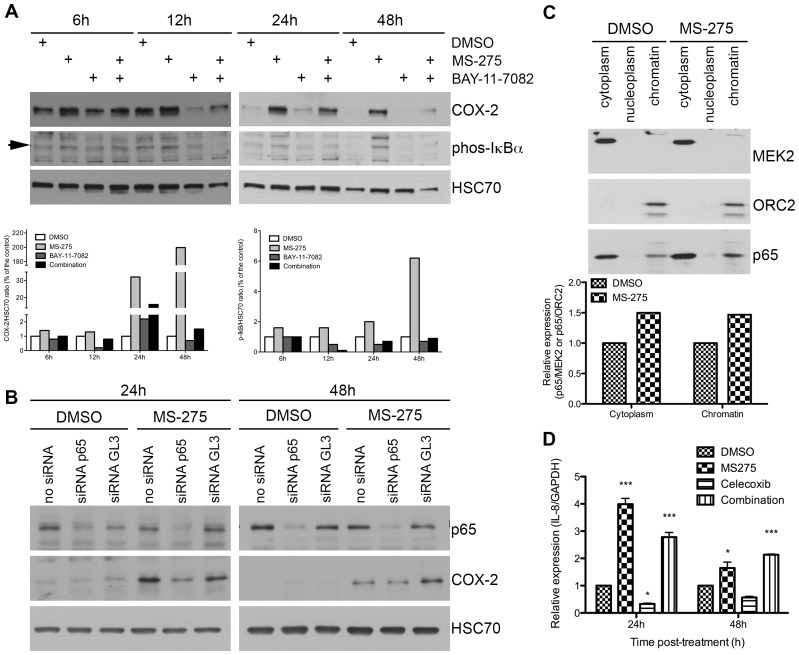
Effect of HDAC inhibition on NF-kB activation in BxPC-3 cells.(A) Effect of an IKK inhibitor (10 µM BAY-11-7082) on 1 µM MS-275-induced COX-2 expression. Phospho-IkBα was used as a control of BAY-11-7082 treatment efficacy. HSC70 was used as a loading control. Densitometry was expressed as a COX-2/HSC70 or IkBα/HSC70 ratio. (B) Western-blot detection of COX-2 in 20 µg BxPC-3 proteins after 1 µM MS-275 treatment and p65 siRNA transfection. HSC70 was used as a loading control. (C) Western-blot detection of p65 in 15 µg BxPC-3 cytoplasm, nucleoplasm or chromatin-associated proteins after 1 µM MS-275 treatment. MEK2 and ORC2 were used as a loading control respectively in cytoplasm and chromatin fractions. Densitometry was expressed as a p65/MEK2 or p65/ORC2 ratio. (D) Time-dependent relative expression of IL-8 mRNA in BxPC-3 cells treated with 1 µM MS-275, 10 µM Celecoxib or a combination of the drugs. Results are expressed as mean ± s.d. ***P<.001, *P<.05 versus DMSO. n≥3 in each condition.